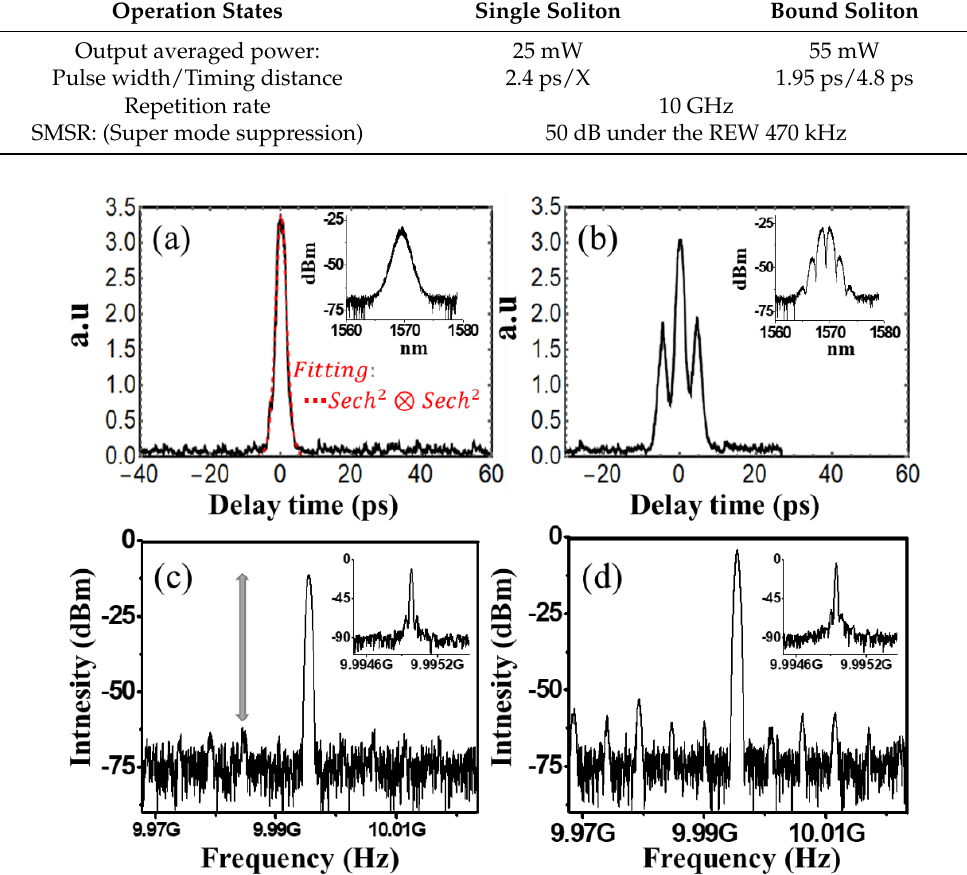
Figure 2. Auto-correlation and optical spectrum measurements for ( a ) single- and ( b ) bound-soliton states respectively. The red dashed line in ( a ) shows the pulse intensity auto-correlation fitting under the sech shape assumption. RF spectrum measurement for ( c ) single- and ( d ) bound-soliton states within the 50 MHz span range with the resolution bandwidth of 470 kHz.